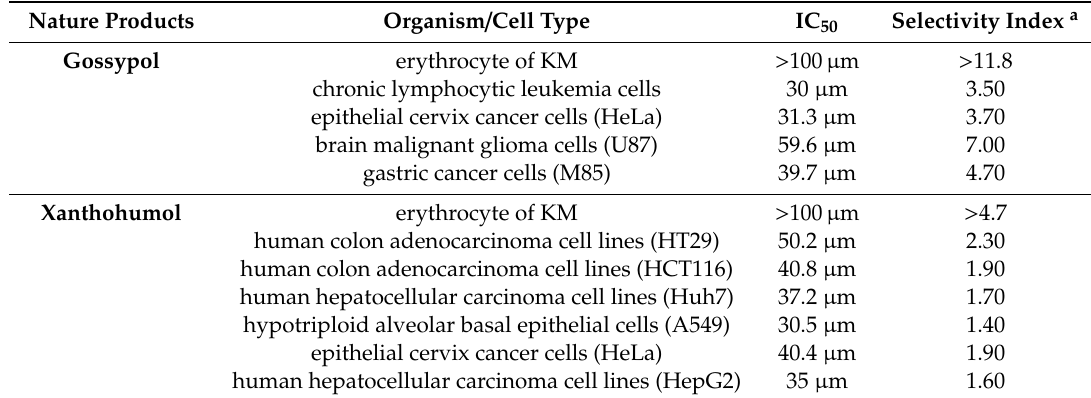
Table 1. The summary of cytotoxicity of gossypol and xanthohumol on di ff erent cell lines.